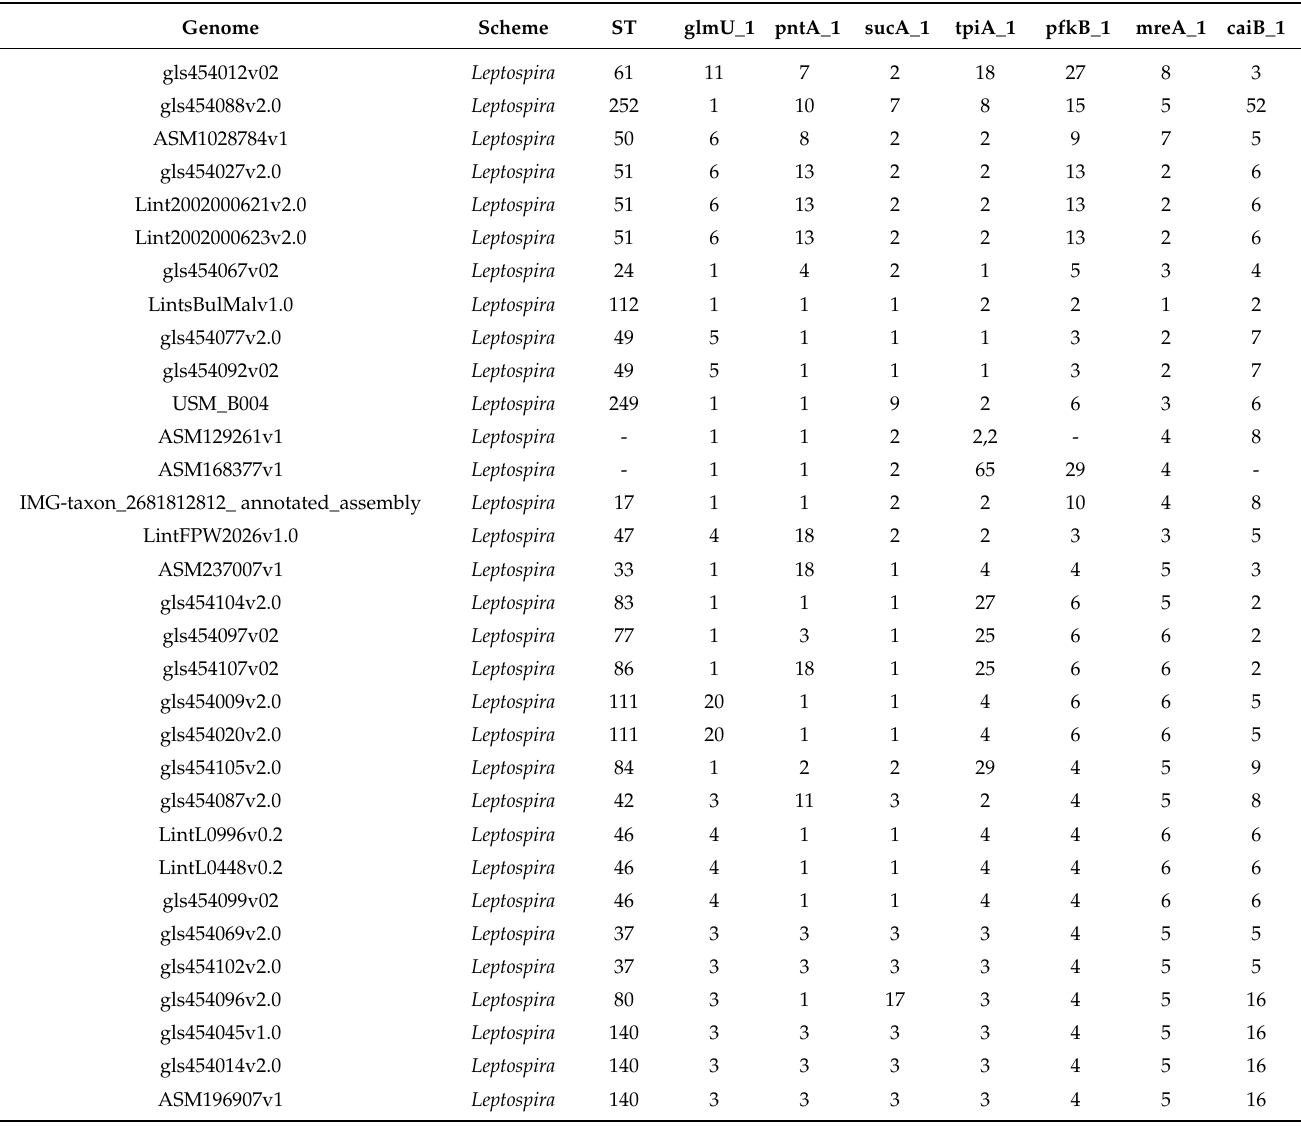
Table 4. Raw output result from the MLST software for L. interrogans